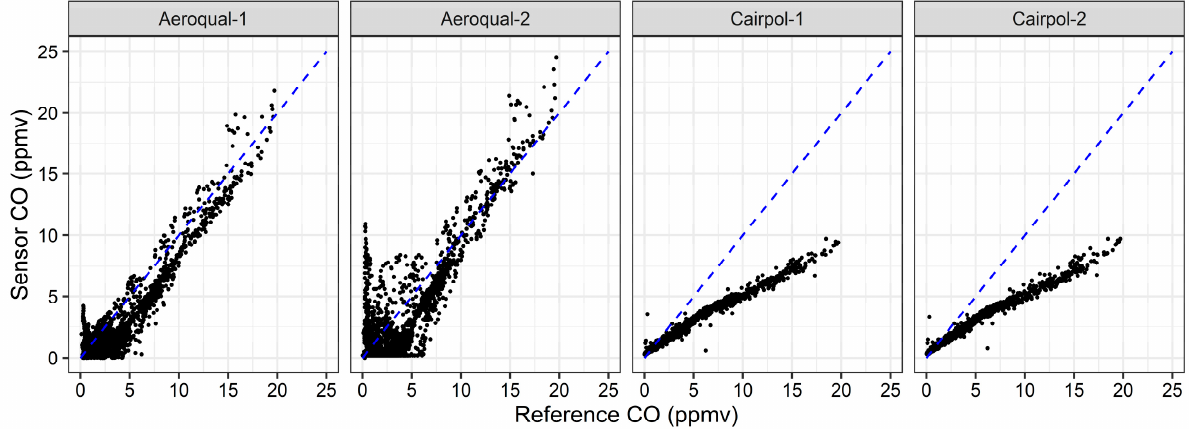
Figure 8. Scatterplot of sensor CO measurements versus reference CO measurements for 33 experi- mental burns at the Fire Sciences Laboratory in 2018.